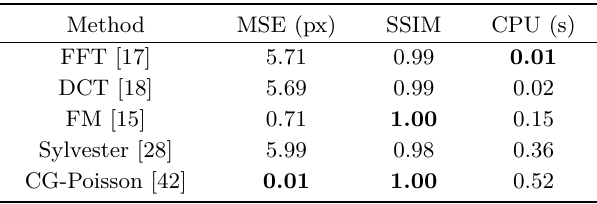
rectangular. The corresponding reconstructed surfaces are shown in Fig.